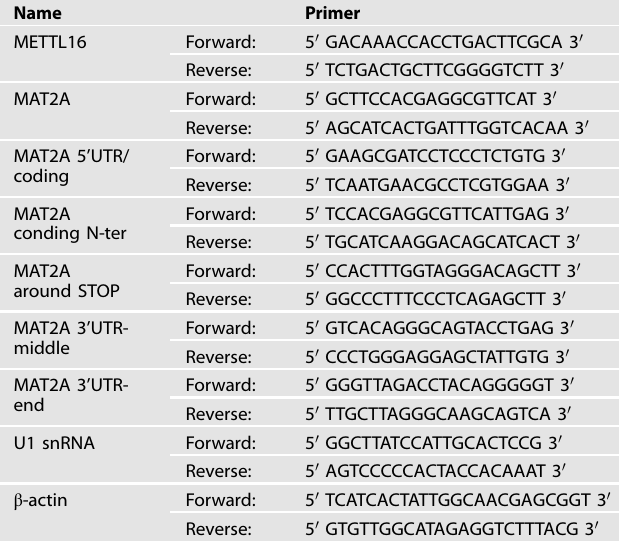
Table 1. The primers used in qRT – PCR